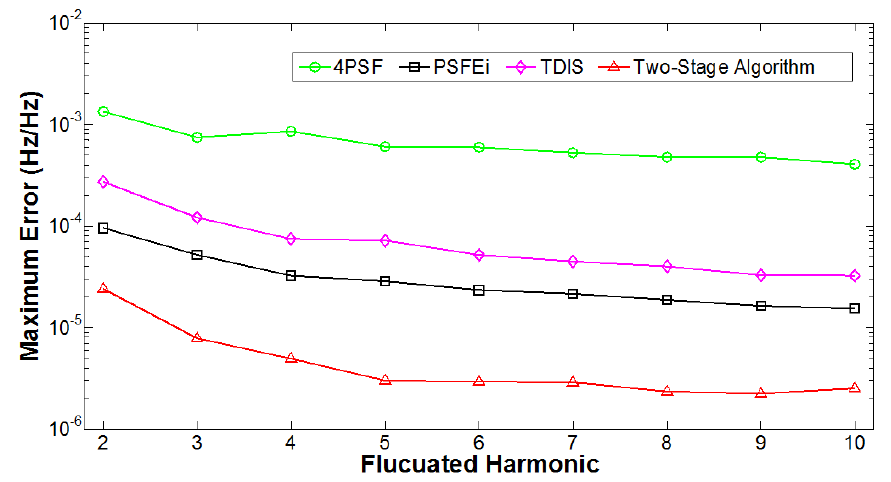
Figure 5. Maximum error of frequency estimation with increasing order of the fluctuating harmonic.